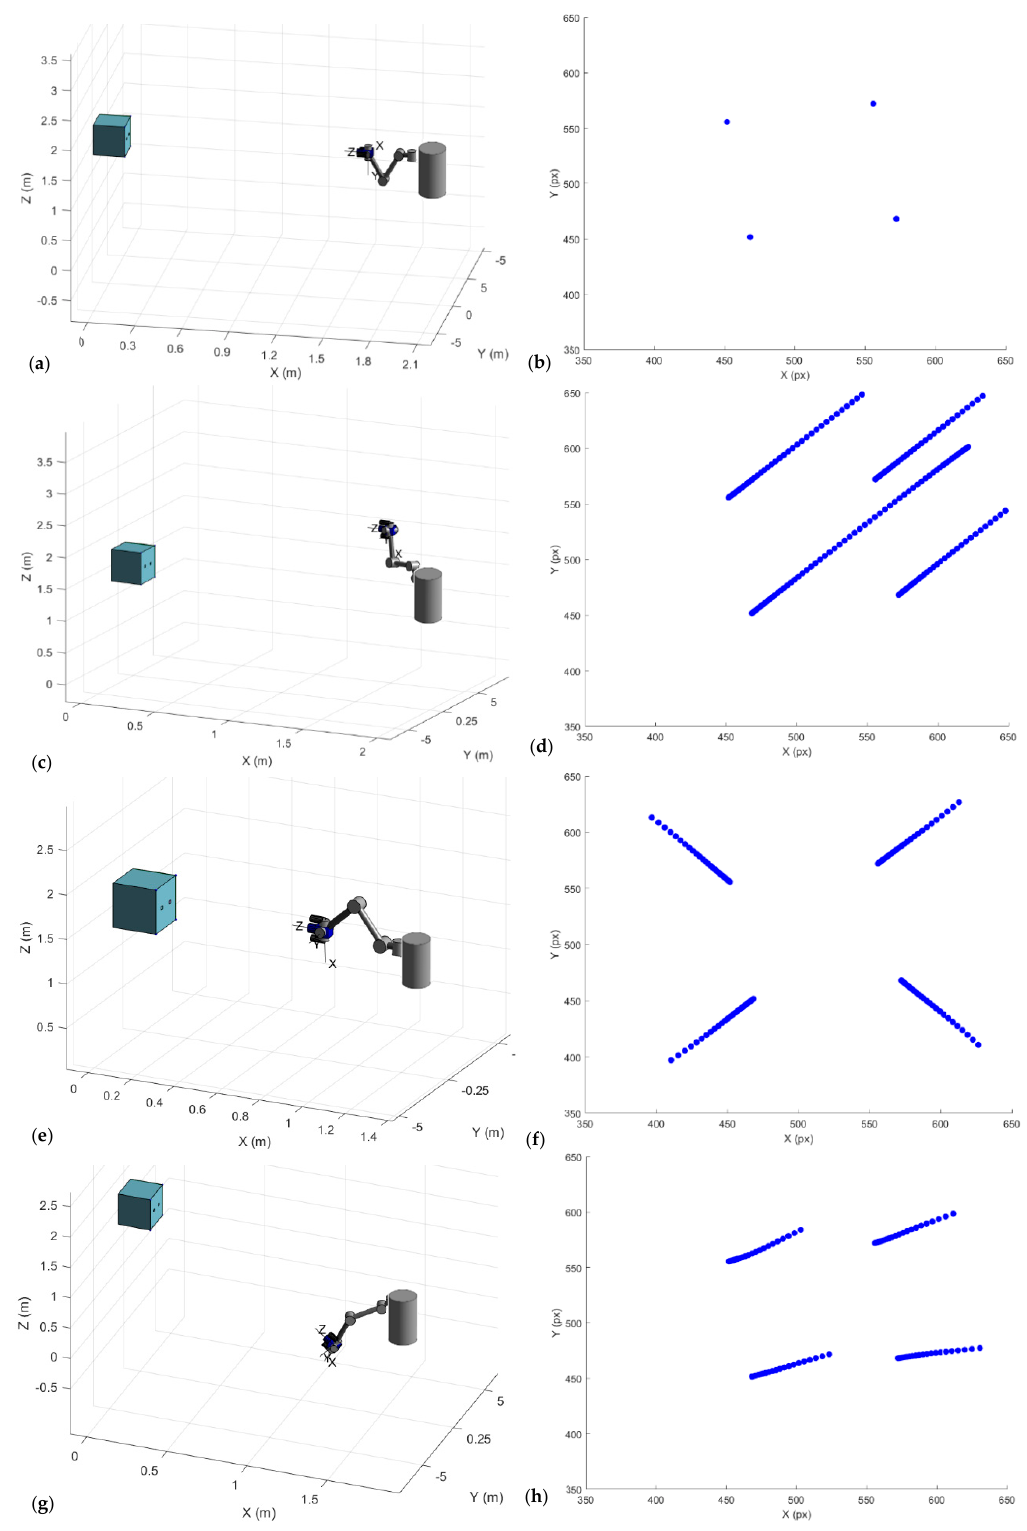
Figure 4. Robot pose and image trajectories in the experiments. ( a ) 3D initial pose of the mobile manipulator and target. ( b ) Initial visual features extracted by the eye-in-hand camera. First experiment: ( c ) 3D final pose. ( d ) Image trajectory. Second experiment: ( e ) 3D final pose. ( f ) Image trajectory. Third experiment: ( g ) 3D Final pose. ( h ) Image